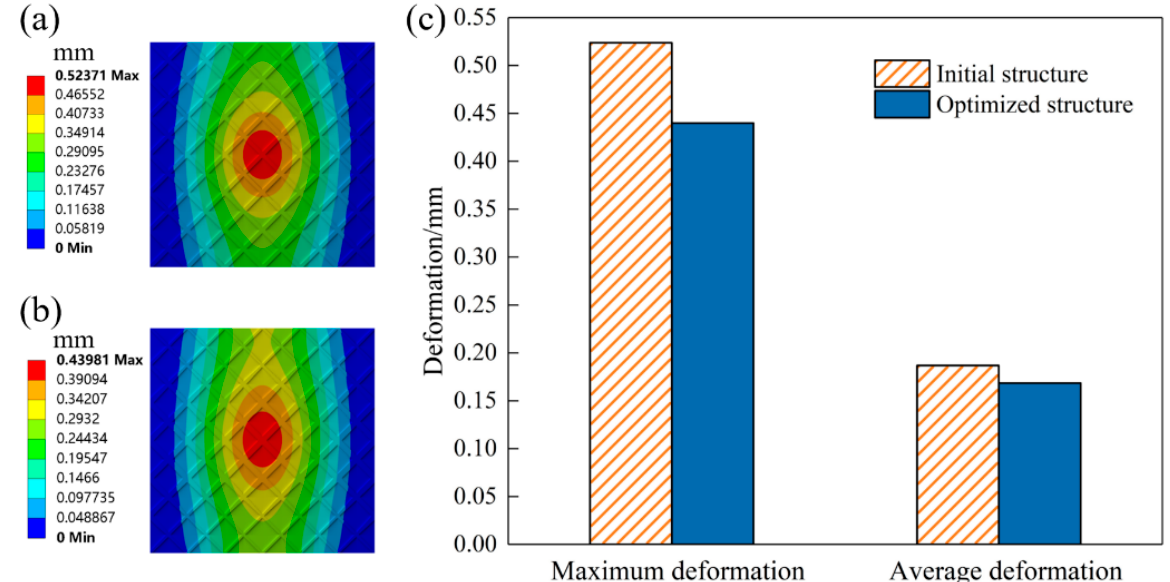
Figure 11. FEA results of TWSS. ( a ) Deformation nephogram of TWSS with uniform stiffening ribs layout. ( b ) Deformation nephogram of TWSS with optimized graded stiffening ribs layout. ( c ) Comparison of the FEA results.